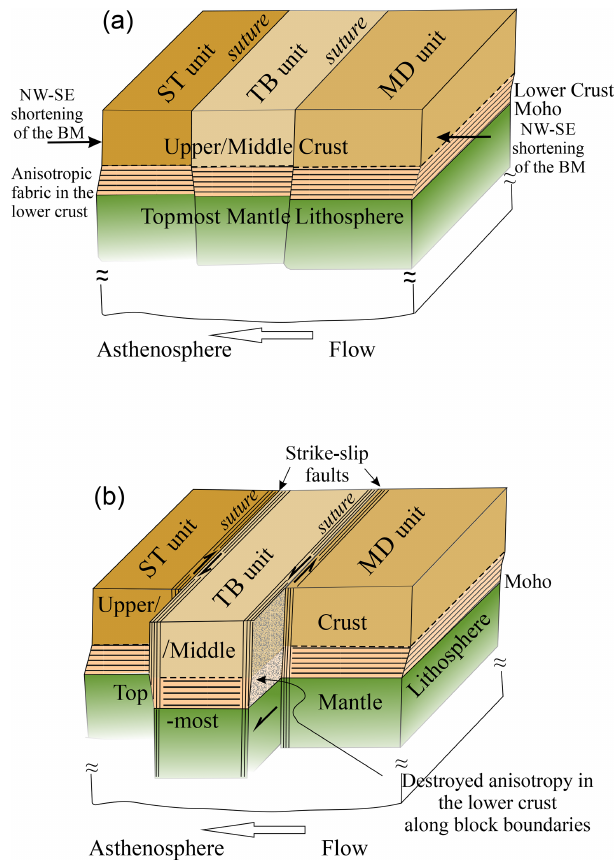
Figure 13. Scheme of tectonic processes affecting the lower-crust fabric. (a) Bottom-driven north-west–south-east shortening of the core of the BM produced or enhanced pre-existing sub-horizontal foliation (fabric) within the lower-crust rocks. (b) Late-Variscan strike-slip fault systems often developed along the pre-existing deep sutures cutting the whole lithosphere. Movement along the sutures might locally modify, overprint, or erase the sub-horizontal fabric of the BM lower